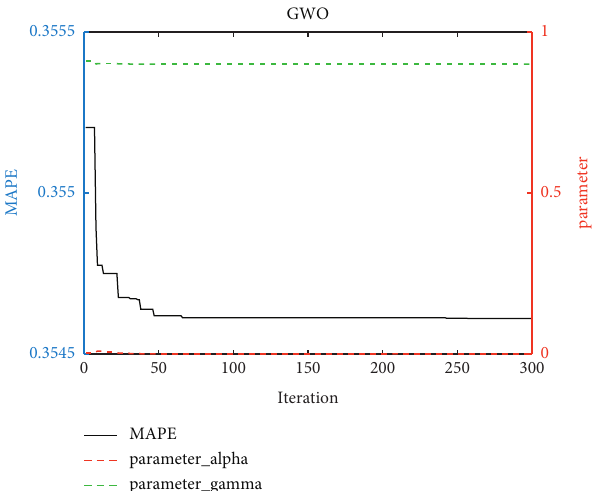
Figure 7: Iterations, MAPE, and parameters of the GWO